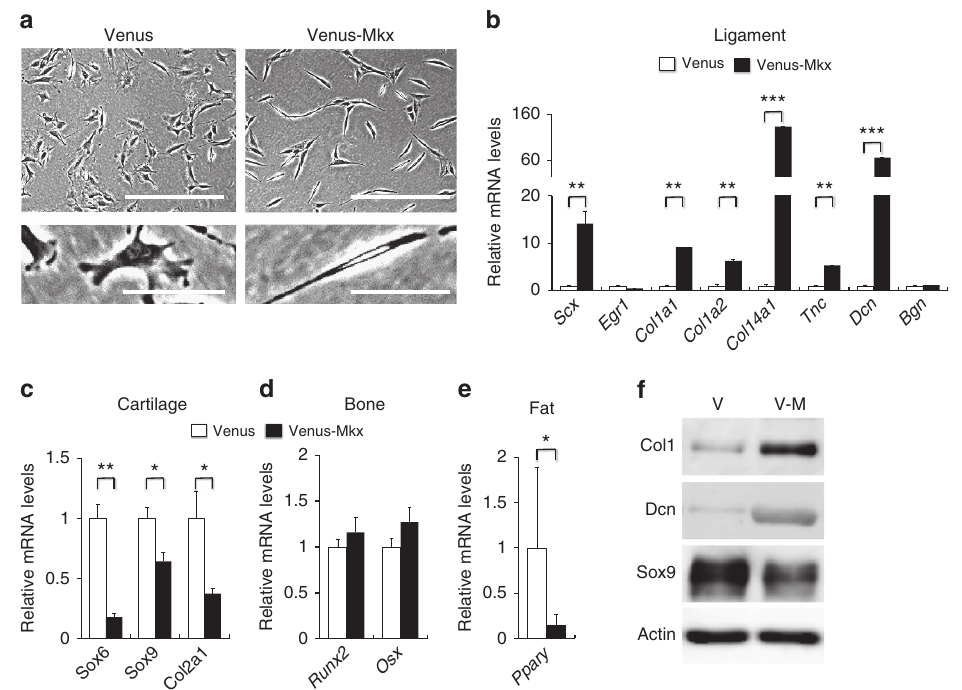
Figure 5 | Mkx promotes the differentiation of mesenchymal stem cells to ligament cells. ( a ) Images of C3H10T1/2 cells induced by Venus (C3H10T1/2-Vor Venus) and Venus-Mkx (C3H10T1/2-VM or Venus-Mkx) in plate culture. Scale bars, 500 m m (top); 100 m m (bottom). ( b – e ) Quantitative real-time reverse transcription PCR (qRT–PCR) analyses of the expression of ligament, cartilage, bone and fat-related genes in C3H10T1/2-V and C3H10T1/2-VM cells. mRNA levels in C3H10T1/2-V cells were normalized to 1. Error bars represent s.e.m. * P o 0.05, ** P o 0.01, *** P o 0.001. Statistical differences were assessed with Student’s t -test. ( f ) Western blot analyses of C3H10T1/2-V and C3H10T1/2-VM cells for lineage